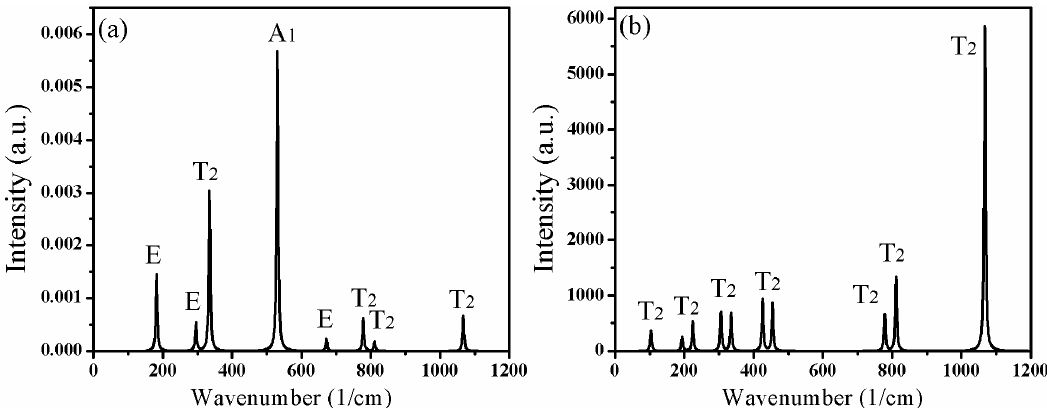
Figure 6. Lattice vibrations and the corresponding active modes of CAO. ( a )Raman scattering spectra and ( b ) IR absorption spectra.